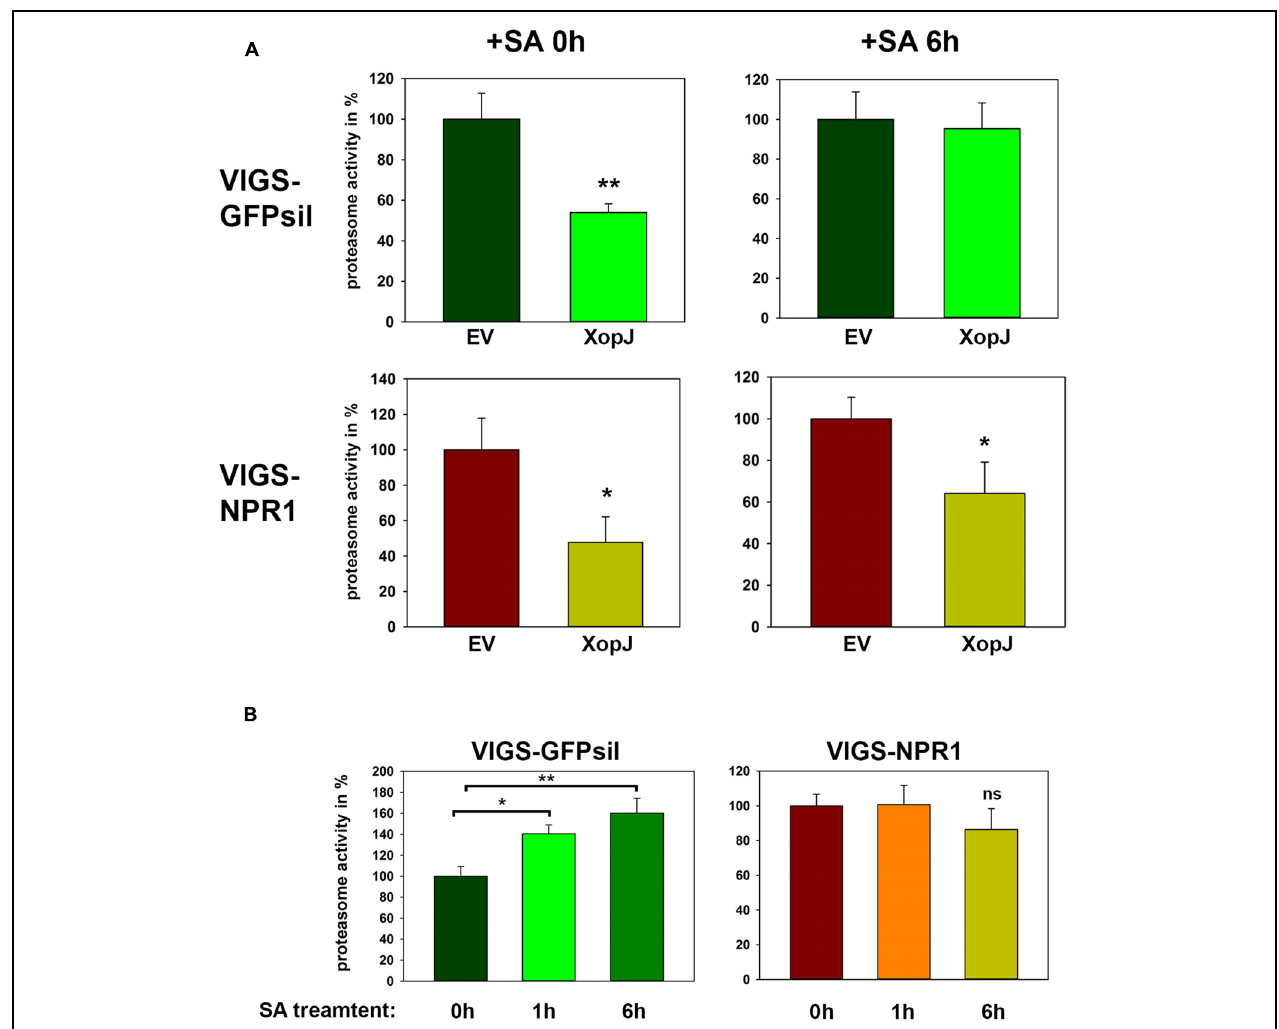
FIGURE 5 | SA treatment interferes with XopJ’s ability to suppress proteasome activity in a NPR1-dependent manner. (A) XopJ along with an EV control were transiently expressed in leaves of TRV:GFPsil and TRV:NPR1 leaves using Agro-infiltration. After 48 h, leaves were sprayed with 5 mM SA and relative proteasome activity in total protein extracts was determined at 0 and 6 h post SA treatment by monitoring the breakdown of the fluorogenic peptide Suc-LLVY-AMC. The EV control was set to 100%. Data represent the mean SD ( n = 3). The asterisk